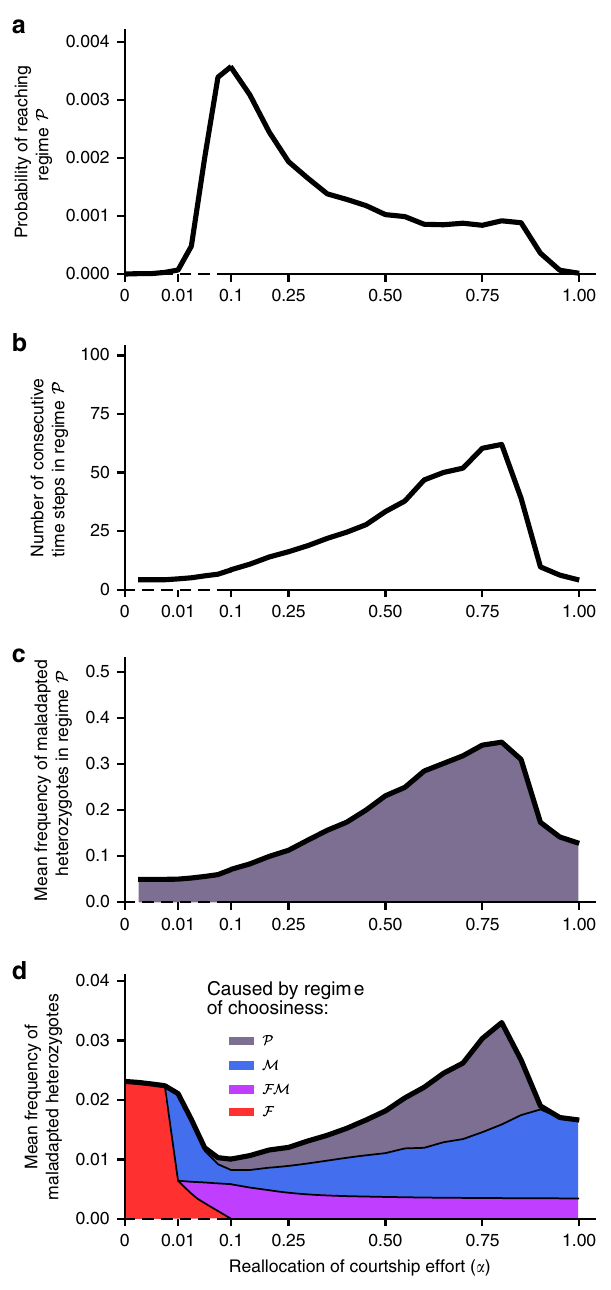
Fig. 5 Coevolutionary dynamics of choosiness ( “ preference cycling ” ) and the resulting hybridization rate in stochastic simulations ( s ¼ 0 : 2, K ¼ 500). To describe the coevolutionary dynamics of female and male choosiness, we record the mean probability of reaching regime P from regime FM or M at each time step ( a ), the mean number of consecutive time steps in regime P ( b ), and the mean frequency of maladapted heterozygotes (Aa at locus A ) in regime P before viability selection ( c ) as a function of the reallocation of courtship effort ( α ). To assess the resulting hybridization rate, we record the mean frequency of maladapted heterozygotes over evolutionary time ( d ). In panel d , we also represent the mean contribution of each regime of choosiness to hybridization. In stochastic simulations, hybridization rate is increased by the coevolutionary dynamics of female and male choosiness despite selection favoring mutual mate choice (when α > 0 : 01) ( d ). In particular, the coevolution of female and male choosiness leads to periodic episodes of random mating, strongly increasing the hybridization rate (with up to 35% of hybridization in